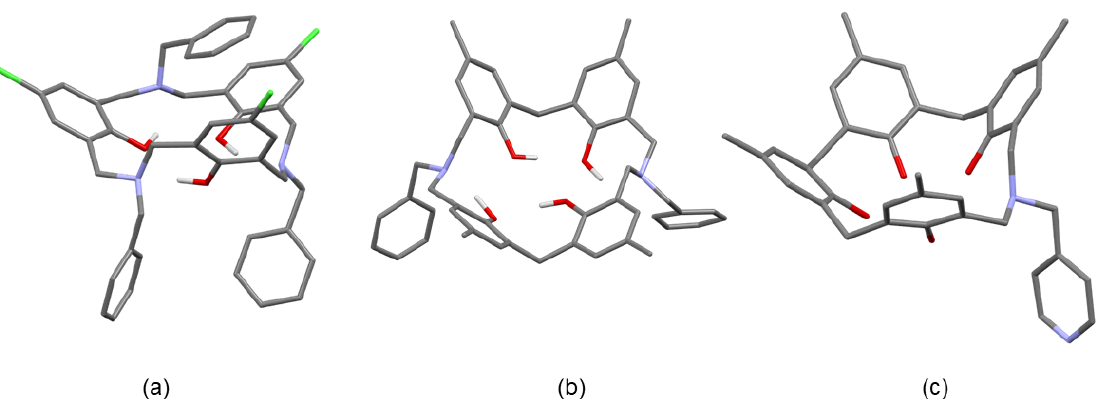
Figure 6. Structures of the azacalixarenes. ( a ) p -Cl- N -benzyl-triazacalix[3.3.3]arene, ( b ) p -Me- N -benzyl-diazacalix[3.1.3.1]arene, and ( c ) p -methyl- N -benzyl-azacalix[3.1.1.1]arene.